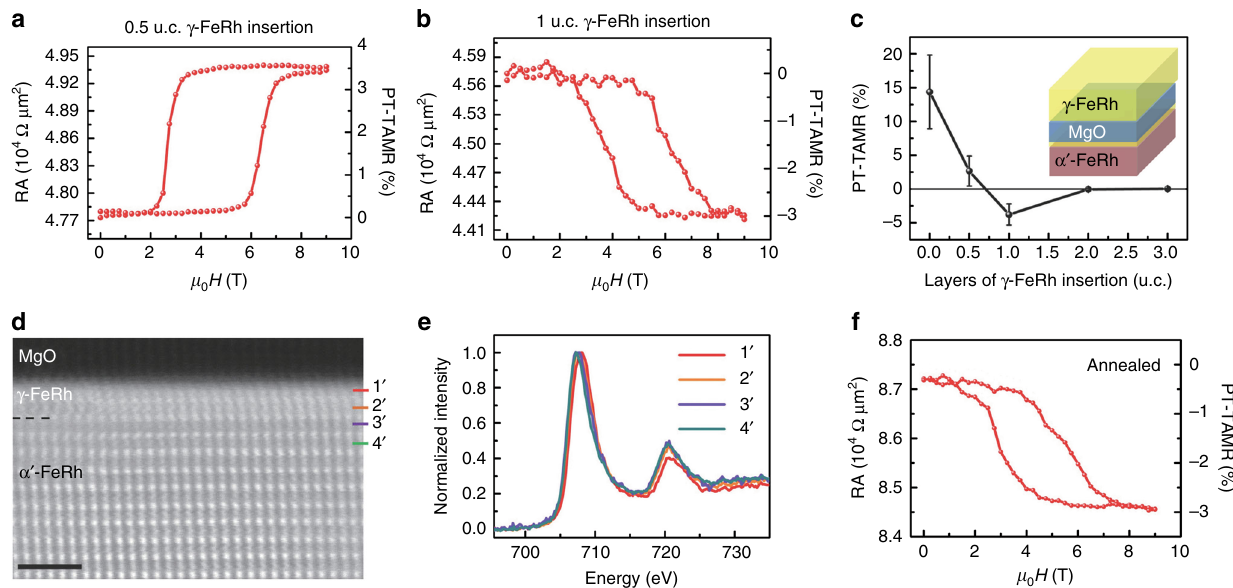
Fig. 5 Tuning the polarity and magnitude of PT-TAMR via interfacial engineering. a , b Magnetic fi eld dependent RA of the α ′ -FeRh-based junctions with intentional insertion of 0.5 u.c. and 1 u.c. γ -FeRh, respectively, between α ′ -FeRh and MgO during the growth, where the PT-TAMR ratio are 3.5% and – 3%, respectively. c A summary of the PT-TAMR ratio as a function of the thickness of γ -FeRh insertion, where the schematic of sample layout is also included. The error bar is estimated by the s.d. of the measured PT-TAMR in fi ve junctions. The bottom α ′ -FeRh and tunneling barrier of MgO are denoted in red and blue layers, respectively. And the insert layer and top electrode of γ -FeRh is shown in yellow . d High resolution STEM Z-contrast image with 2 u.c.-thick γ -FeRh naturally superimposed at the α ′ -FeRh/MgO interface in the annealed junctions. Scale bar is 1 nm in length. e EELS of Fe is marked as 1 ′ – 4 ′ (marked in d ) in the order of increasing the distance from the interface with ~0.3 nm gap. f Typical PT-TAMR curve for the annealed with a